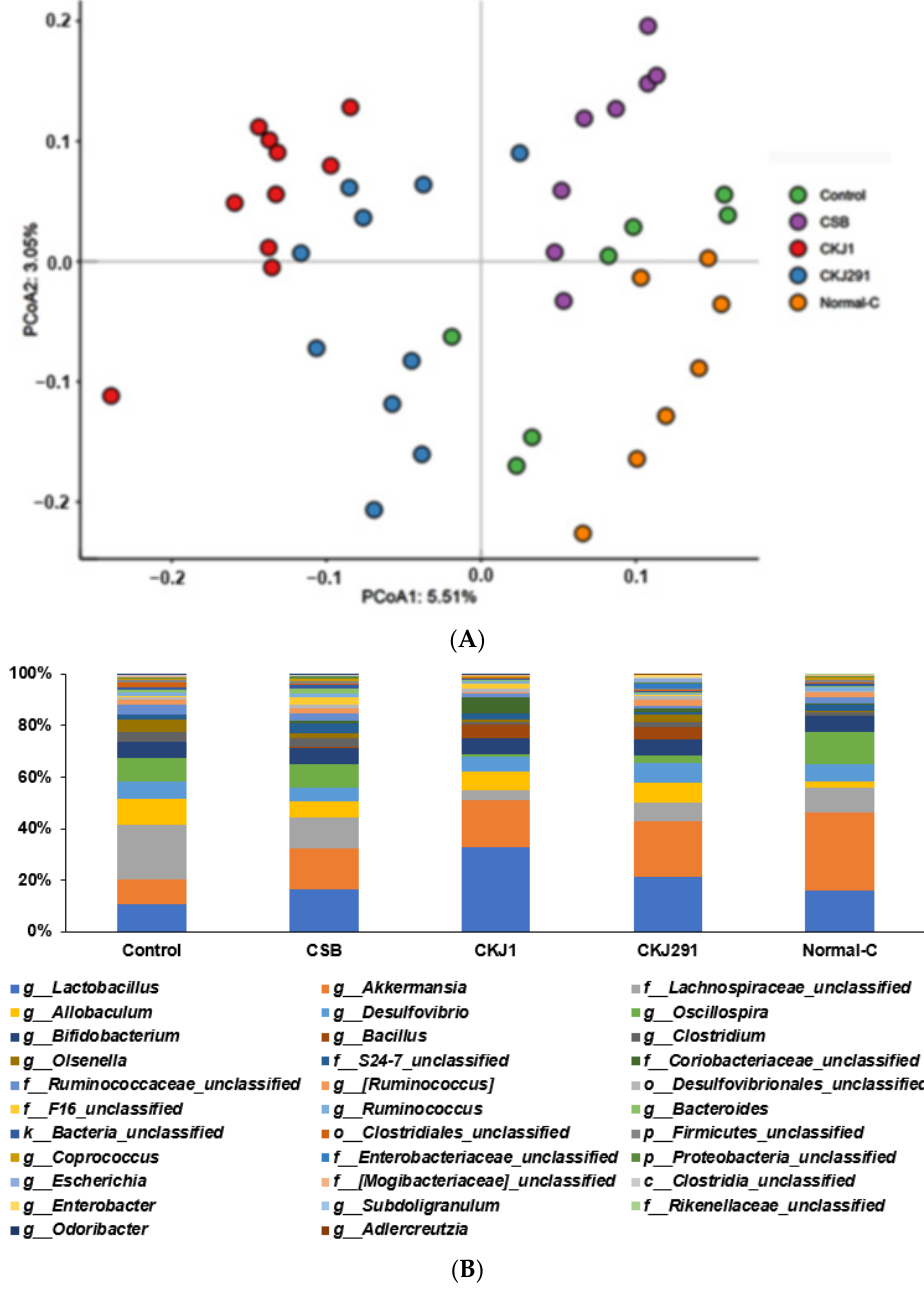
Figure 6. The profiles of gut microbiomes. The principal coordinate analysis (PCoA) of the fecal bacterial community ( A ) and the relative abundance of gut bacteria at the genus level ( B ) were analyzed from the feces in the cecum. Bars represent means ( n =